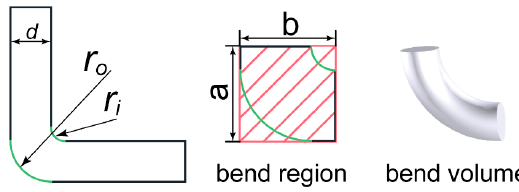
Figure 13. Design for a smooth transition C- r i / r o .